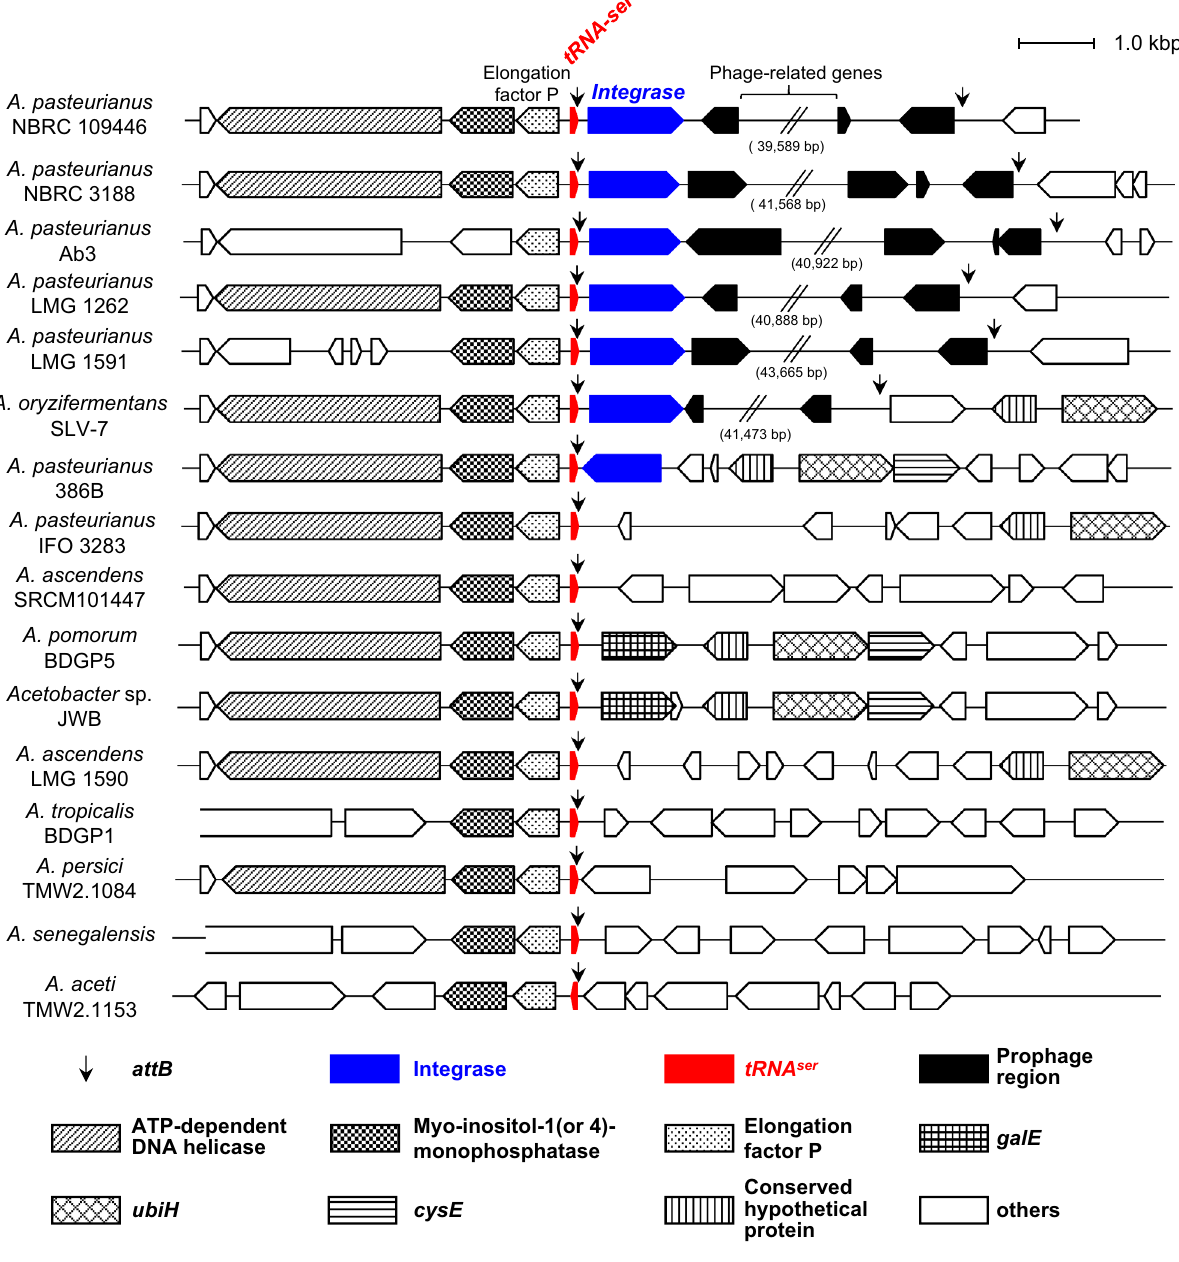
Figure 4. Gene organization of tRNA ser gene locus in Acetobacter spp. The gene compositions and arrangements located in the tRNA ser locus of Acetobacter spp. are shown. The upstream region of tRNA ser was highly conserved among the genus of Acetobacter . Arrowheads indicate the putative attB sites. Genes for tRNA ser and integrase are indicated by red and blue-colored arrowheads,